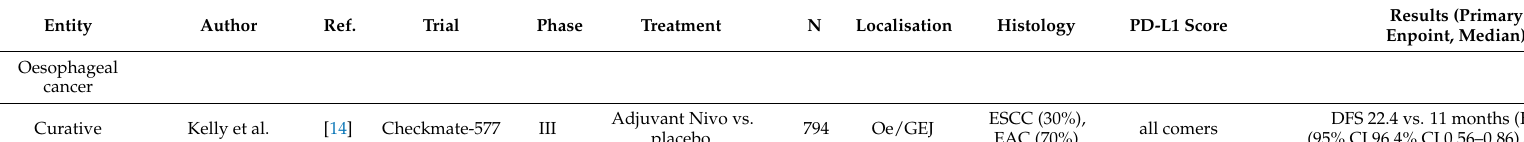
Table 1. Overview of immune checkpoint inhibitor clinical trials in oesophago-gastric